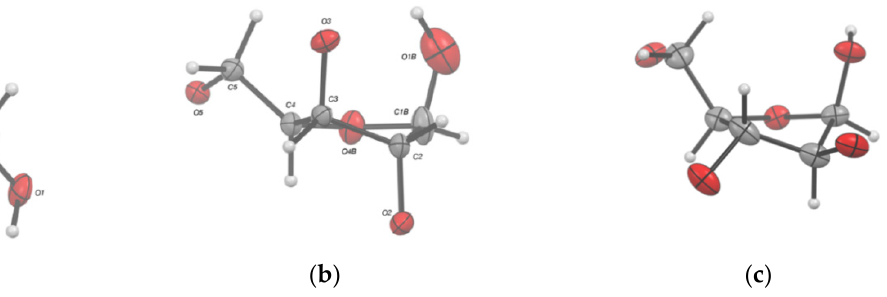
Figure 1. ( a ) Molecular structure of ( α )- 1 with numbering scheme and anisotropic displacement el- lipsoids drawn at the 50% probability level, hydrogen atoms being represented by spheres of arbi- trary radius ; ( b ) Ortep view of the minor ( β )- 1 compound. Dotted line in cyan highlights the intra- molecular h-bond.